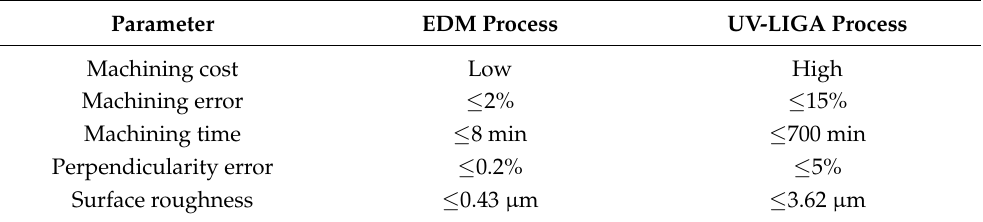
Table 6. Process comparison.